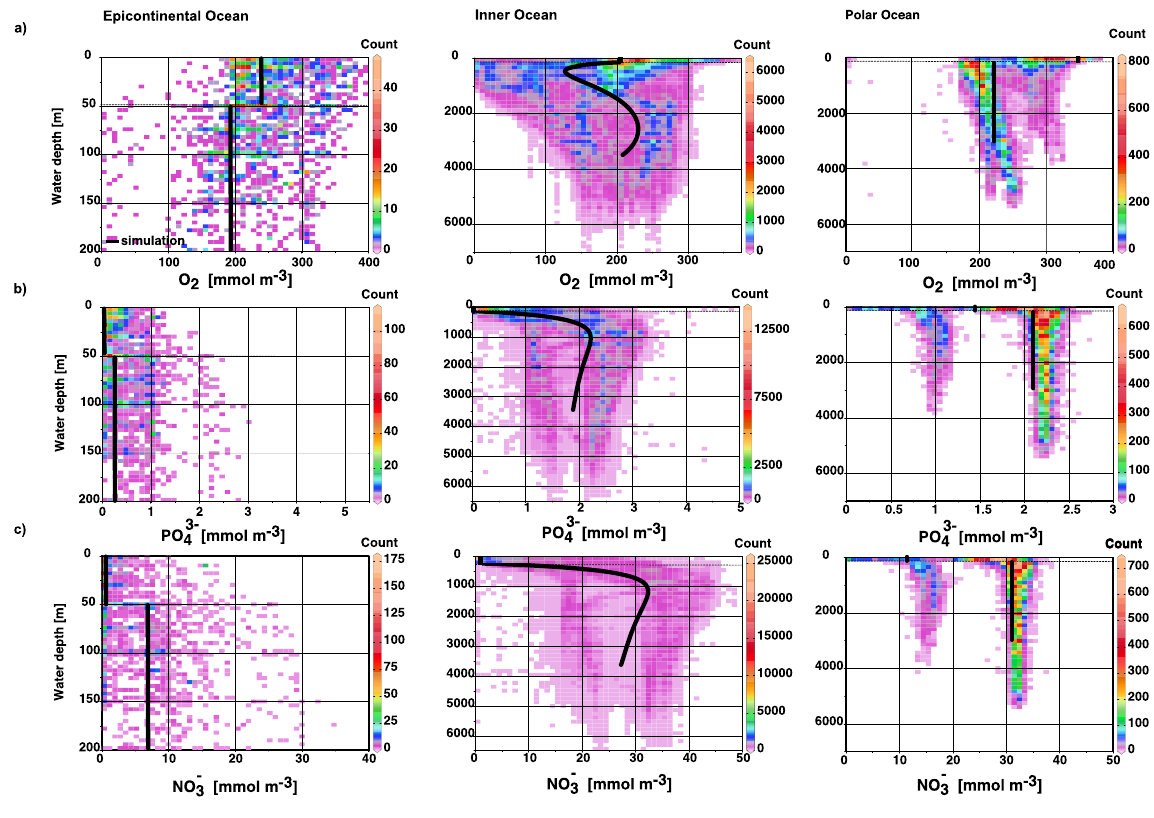
Fig. 5. Simulated steady state depth-profiles of (a) oxygen, (b) phosphate and (c) nitrate in the epicontinental, inner and polar ocean (black line). Simulation results are compared to the dataset from the WOCE Hydrographic Program (*hy1.csv files from WHPO web-site as of 27 May 2002). The colour code indicates the number of times a concentration is reported for a given water depth.